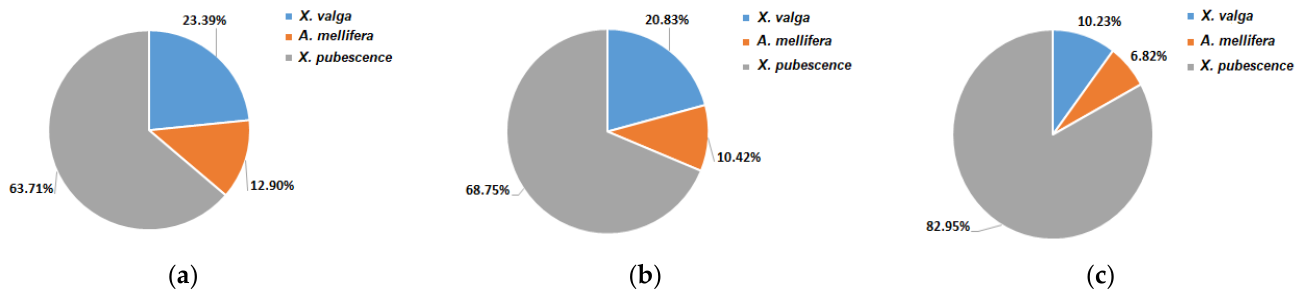
Figure 7. Number of positive visits per pollinator species on: ( a ) white-colored flowers; ( b ) white/purple-colored flowers; ( c ) purple-colored flowers; and ( d ) light purple-colored flowers. This fact shows that color may influence pollinator visitation, but it is not the primary factor of enhancing their foraging [28]. Similarly, while most positive visits were recorded on accessions which exhibited their racemes above the canopy, visitation was not only increased to these accessions (Figure 8). This observation suggests that raceme position performs a role in pollinator attraction and visitation as in other plant species [58], but likely interacts with other factors and is not sufficient to predict accurately cowpea visitation preferences.